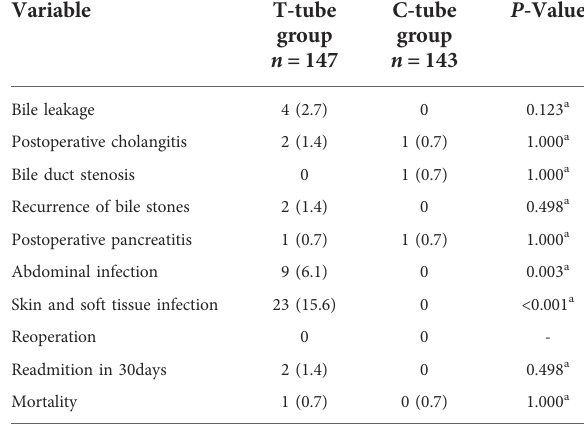
TABLE 3 Postoperative complications of patients in each